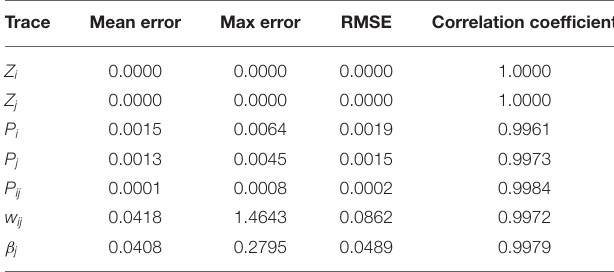
TABLE 2 | Five-second simulation results with dense spikes in